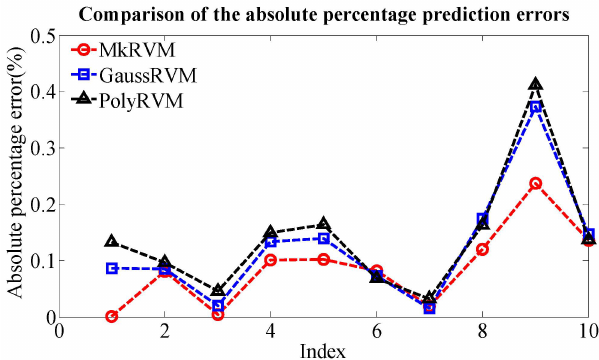
Figure 12. The comparison of the absolute percentage predictionerrors among the MkRVM, GaussRVM and PolyRVM.